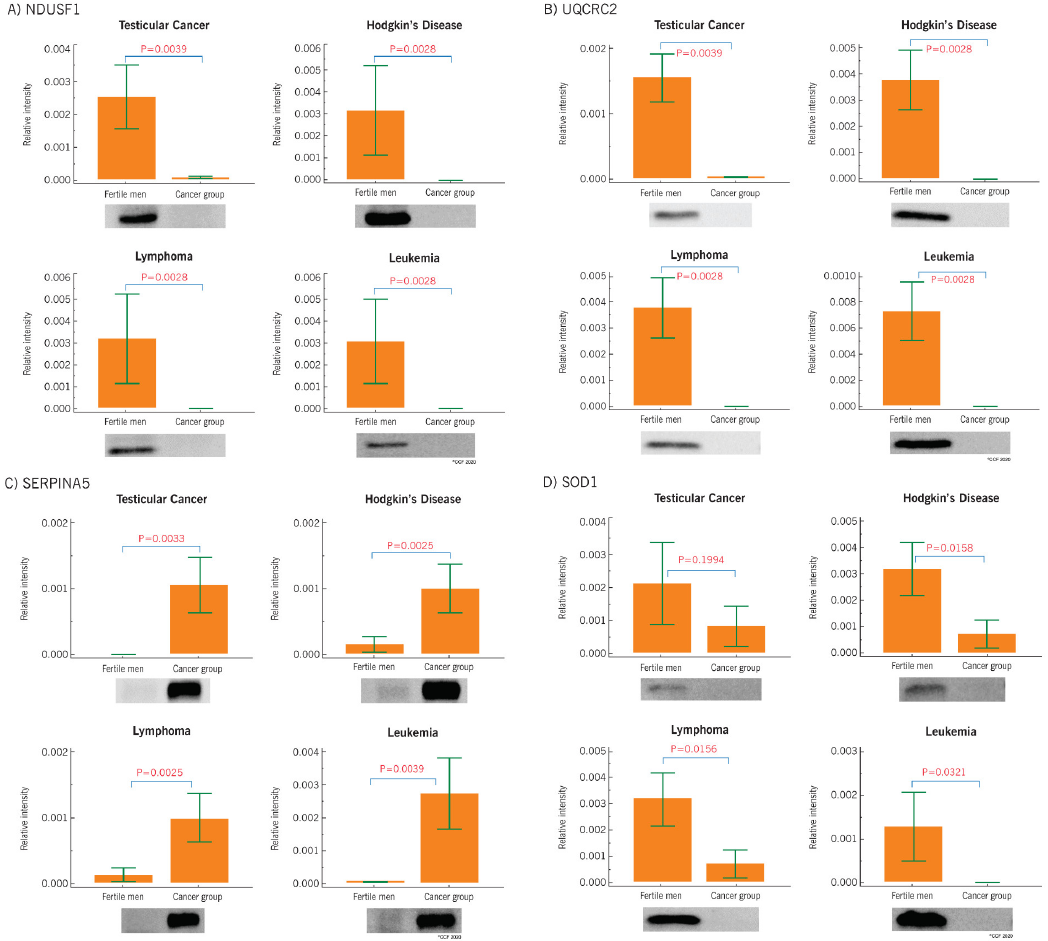
Figure 6. Western blot analysis of ( A ) NDUFS1 ( B ) UQCRC2, ( C ) SERPINA5 and ( D ) SOD1 in spermatozoa of cancer patients compared to fertile men.